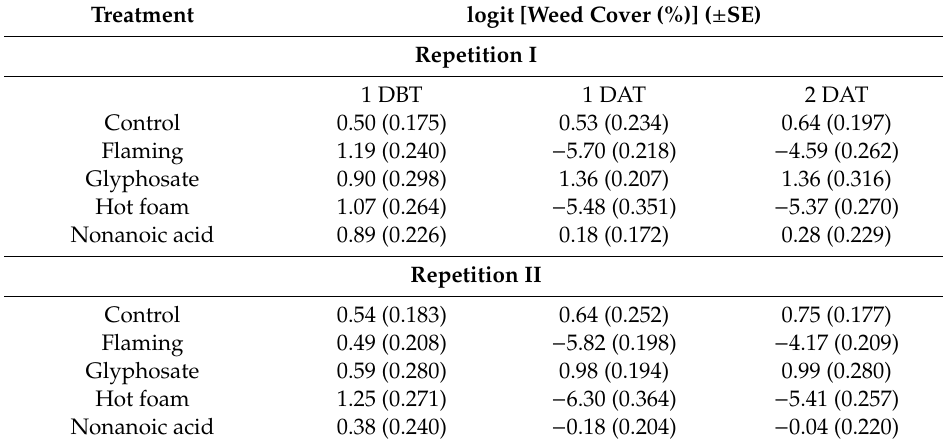
Table 3. Weed control least squares means and SE of weed cover percentage logit transformed as a ff ected by the di ff erent treatments, repetition of the experiment, and evaluation date (one day before, and one and two days after treatments) at site II.